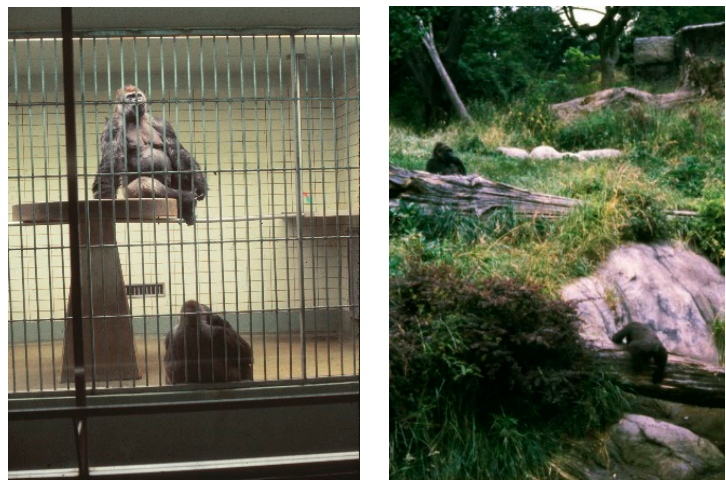
Figure 2. ( Left ) sterile zoo gorilla display and ( Right ) landscape immersion gorilla display at Woodland Park Zoo with many naturalistic enrichment features. Both were photographed in 1978 (Photos: J. Coe).